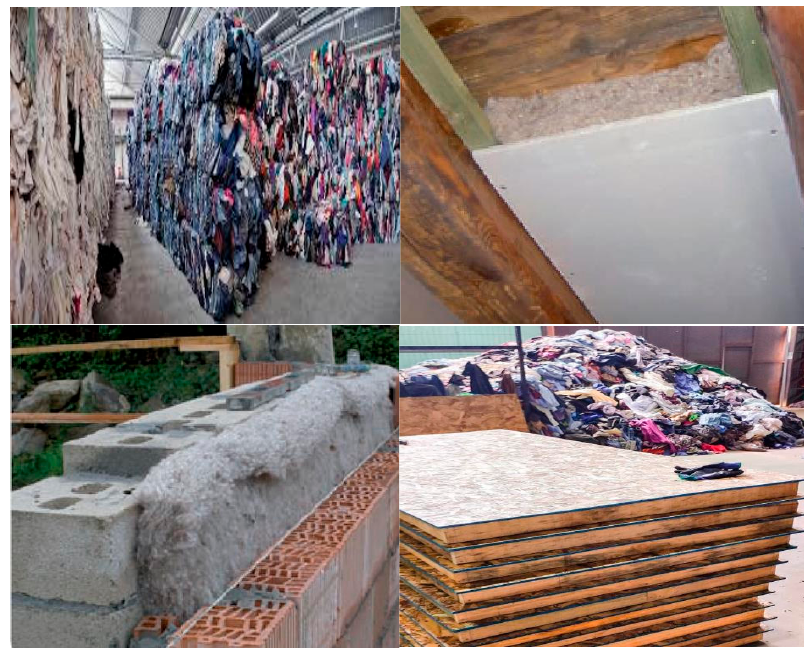
Figure 1. The process of recycling textile waste into ecological panels.